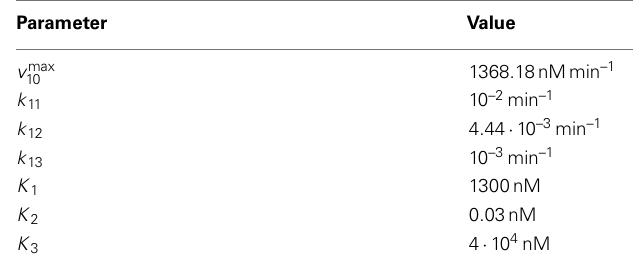
TableA3 | Kinetic parameters of the iFFL motif.